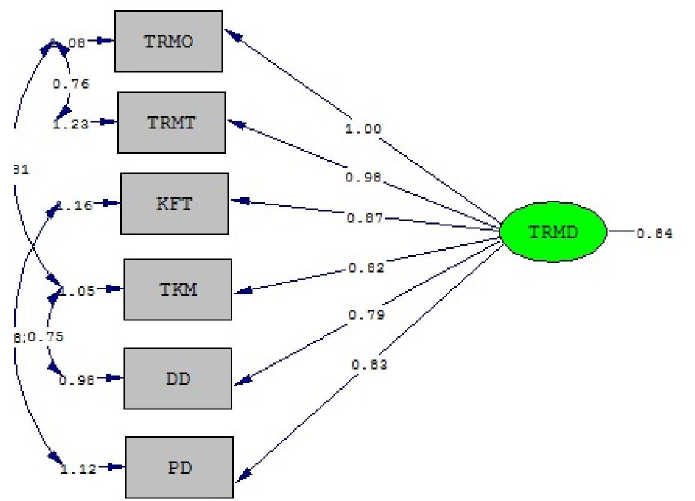
Fig. 2. Path analysis depicting observed and latent